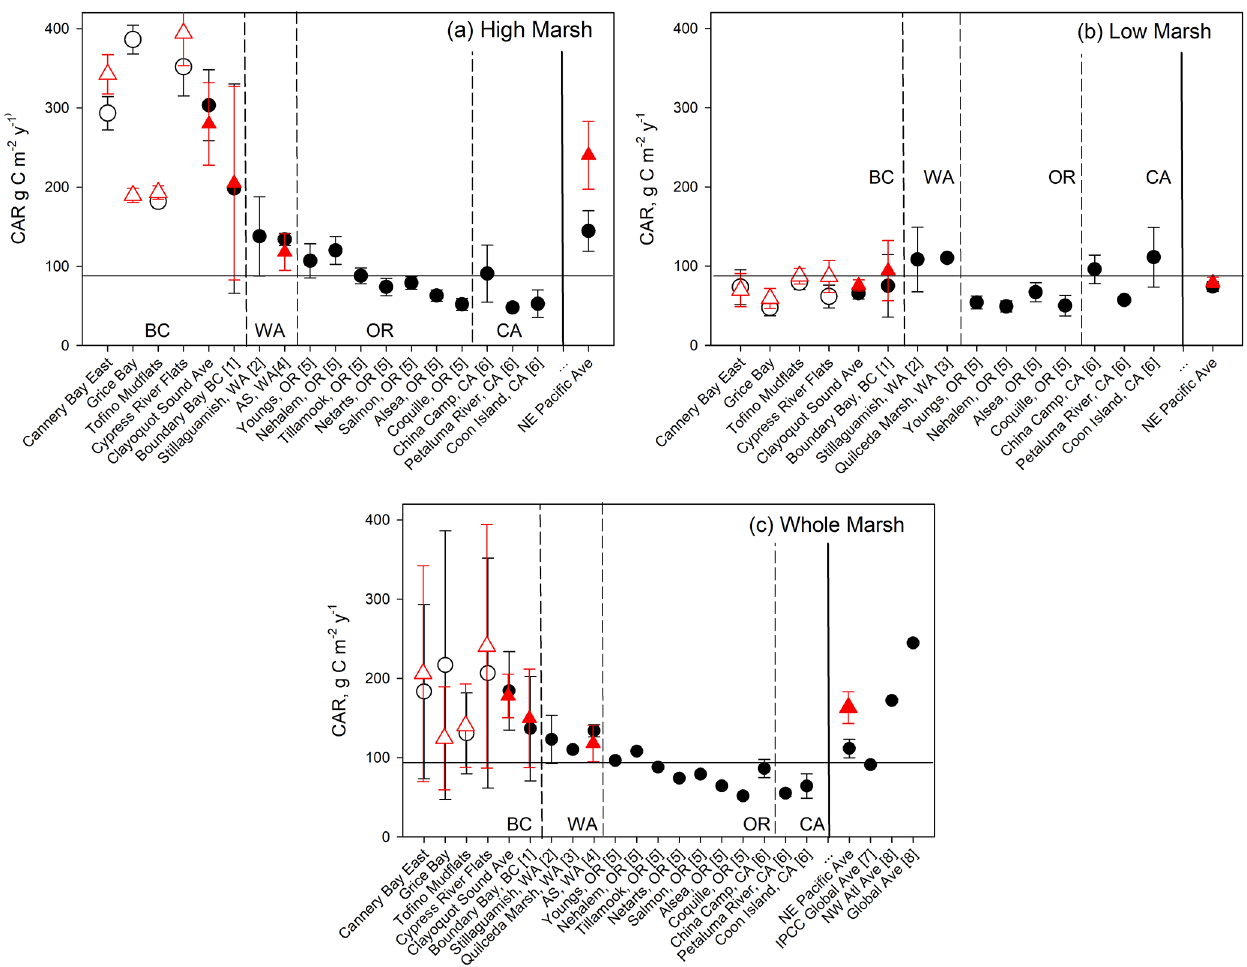
Figure 7. Comparison of Clayoquot Sound CARs with other salt marshes with 210 Pb dating, for whole-core (black circles) and 30-year (red triangle) estimates. Individual Clayoquot Sound marshes are indicated with open symbols followed by a regional mean ( ± SE). Additional site data taken from (1) Boundary Bay, BC, Canada (Gailis et al., 2021); (2) Stillaguamish, WA, USA (Poppe and Rybczyk, 2021); (3) Snohomish Estuary, WA, USA (Crooks et al., 2014); (4) Animal Slough (AS) in southern Puget Sound, WA, USA (note that red triangle is 50-year average; Drexler et al., 2019); (5) coastal OR, USA (Peck et al., 2020); and (6) San Francisco Bay, CA, USA (Callaway et al., 2012). Global and other regional averages are taken from (7) Kennedy et al. (2013) and (8) Ouyang and Lee (2014); only a fraction of data ( < 10%) in (8) were dated using 210 Pb. Horizontal line represents Kennedy et al. (2013) global